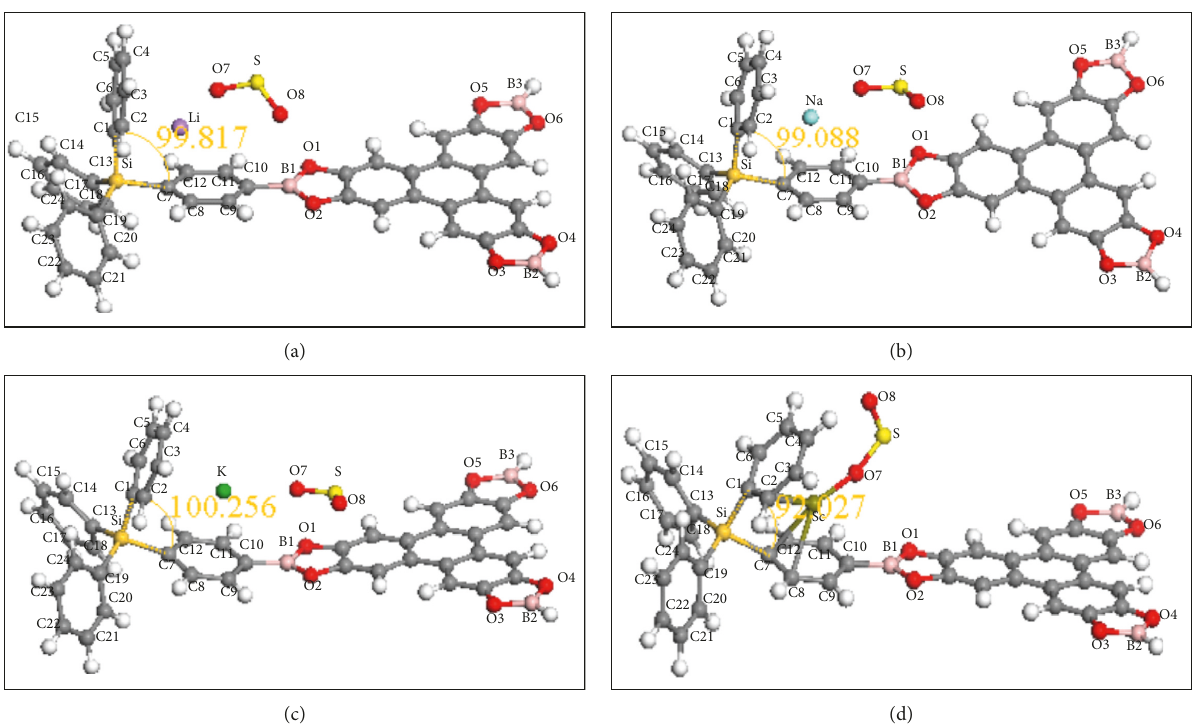
Figure 4: Optimized geometries of all the adsorption complexes SO 2 /metal@COF-105. Dark yellow: Si; black: C; grey: H; pink: B; red: O; purple: Li; blue: Na; green: K; khaki: Sc; yellow: S. Partial atom numbers of C, B, and O atoms were presented. (a) SO 2 /Li@COF-105. (b) SO 2 /Na@COF-105. (c) SO 2 /K@COF-105. (d) SO 2 /Sc@COF-105. Table 3: Partial geometrical data of the adsorption complexes SO 2 /metal@COF-105. Angle ( ° )/atom distances